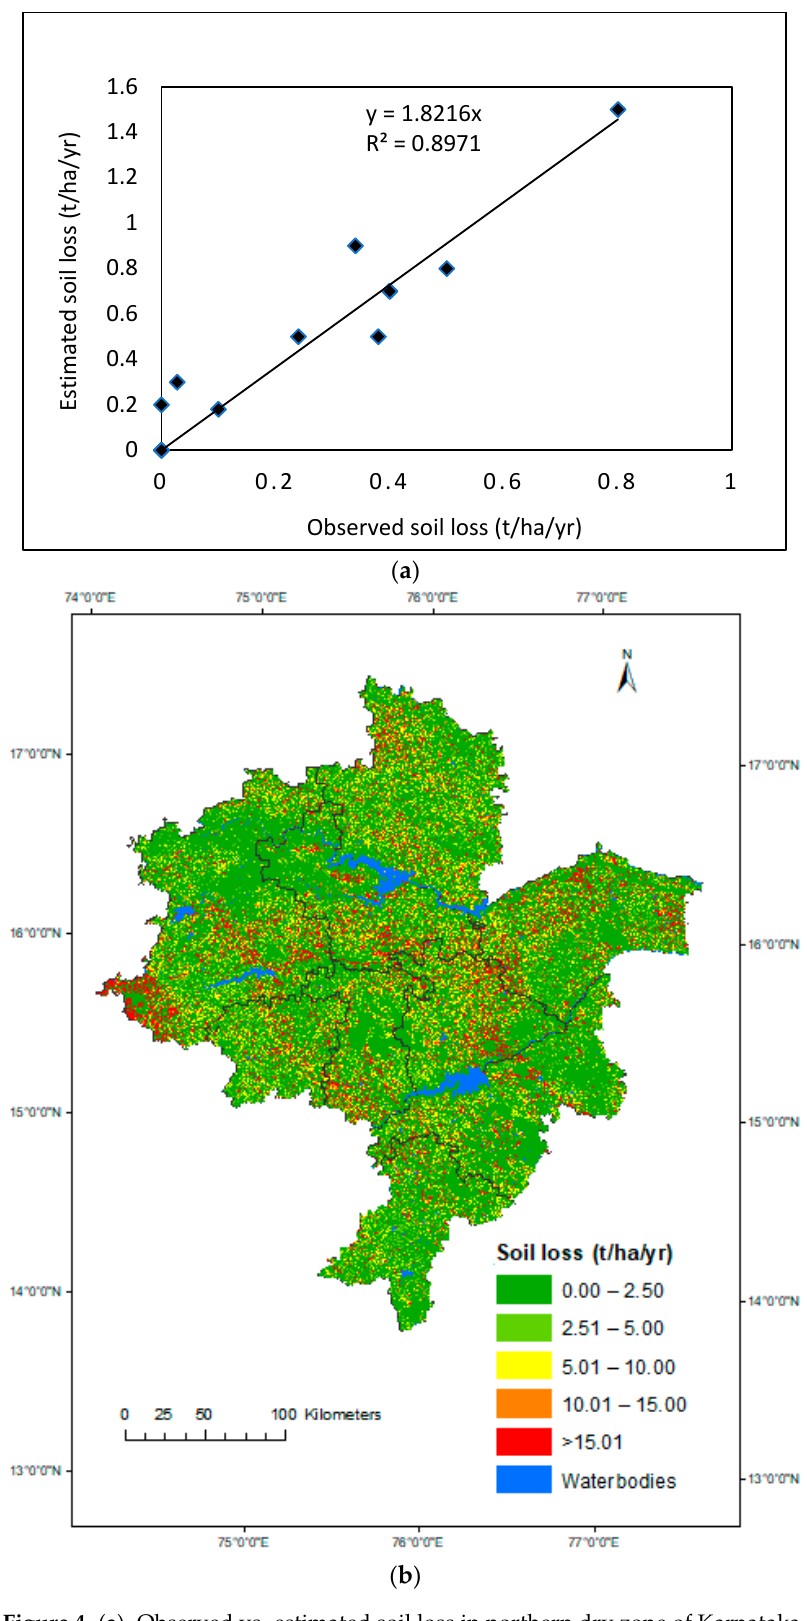
Figure 4. ( a ). Observed vs. estimated soil loss in northern dry zone of Karnataka. ( b ). Mean annual soil loss in northern dry zone of Karnataka.